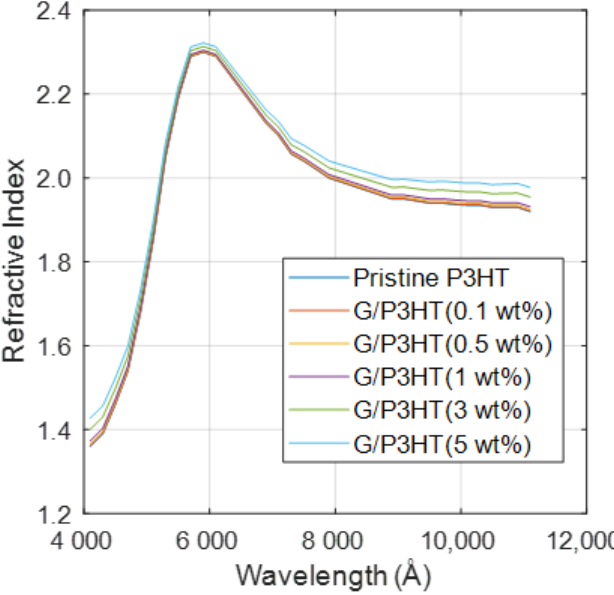
Figure 3. Refractive index of the six different P3HT/G nanocomposites calculated with the rule of